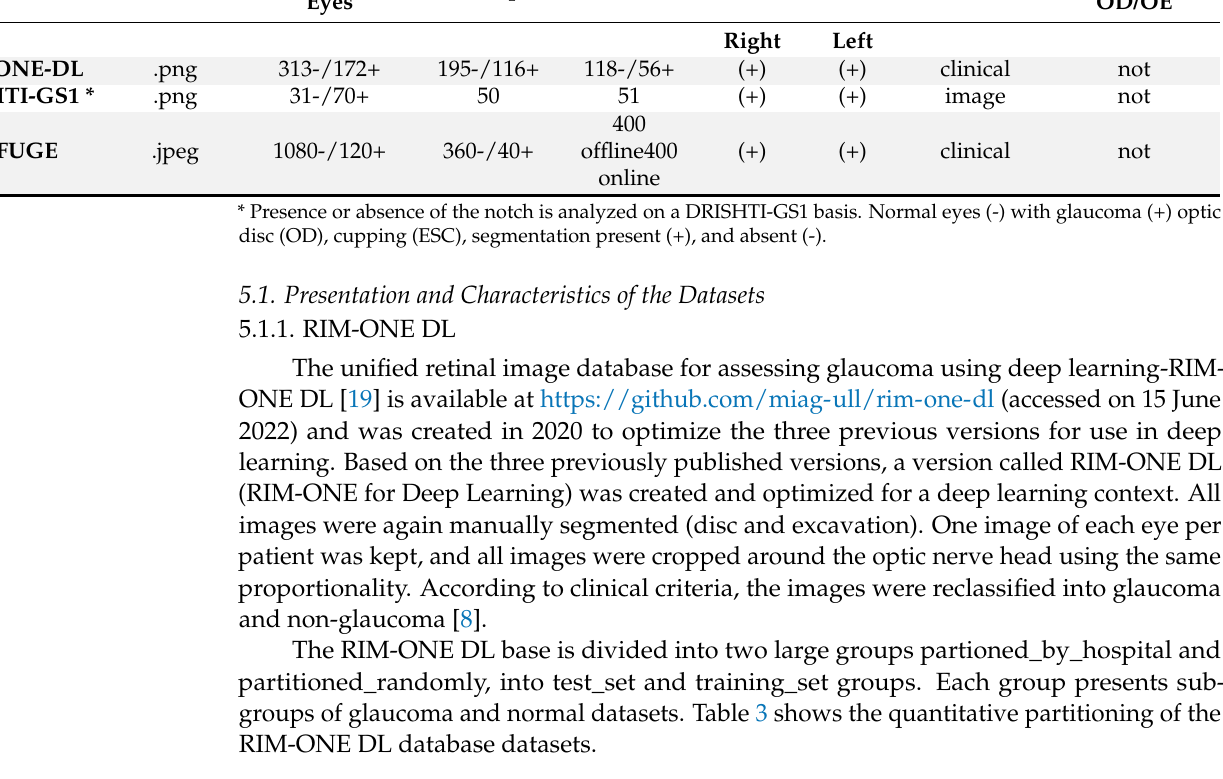
Table 3. Presentation of the RIM-ONE DL database